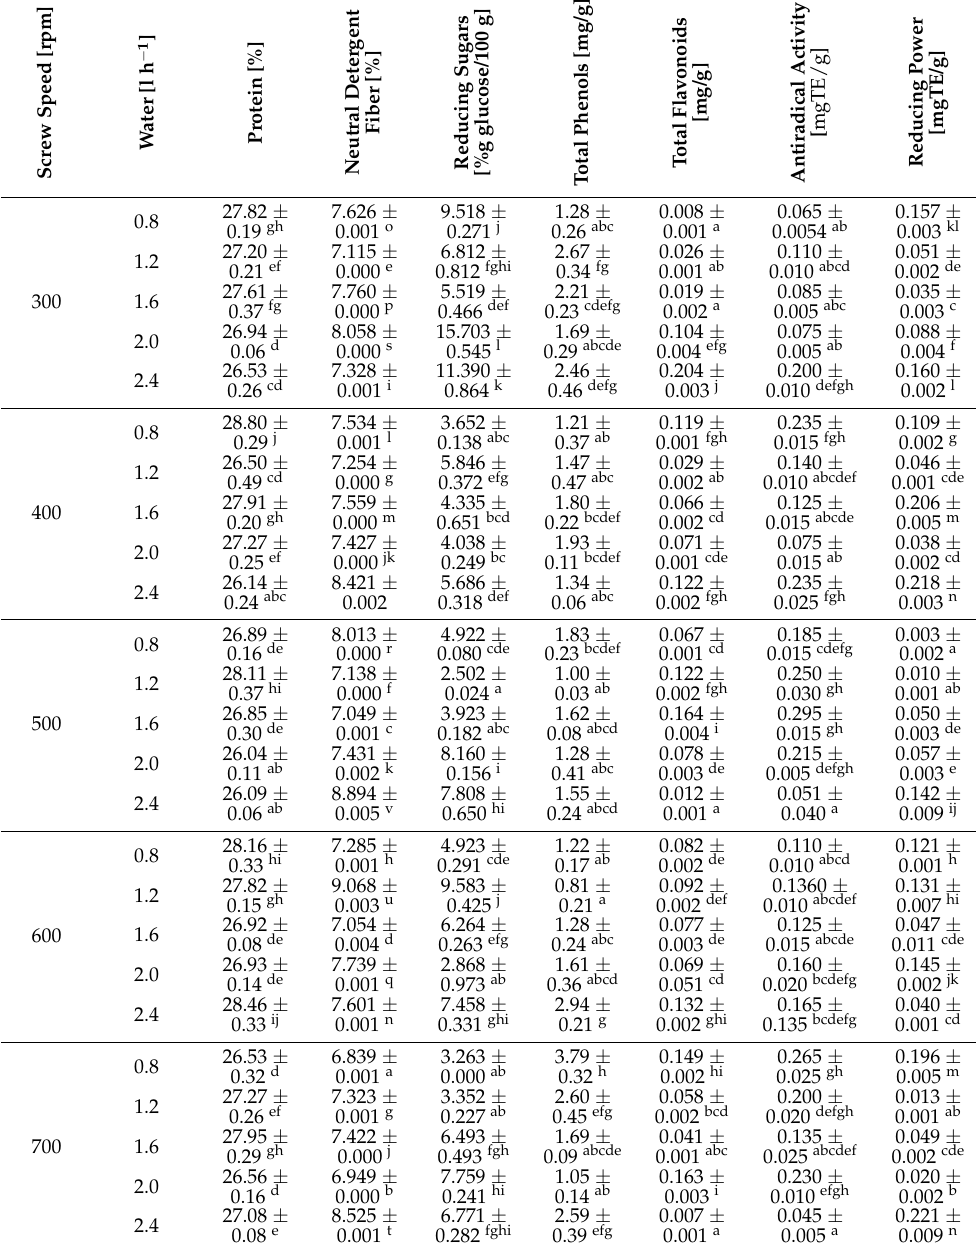
Table 2. Chemical and nutritional characteristics of white bean Aura extrudates processed at various